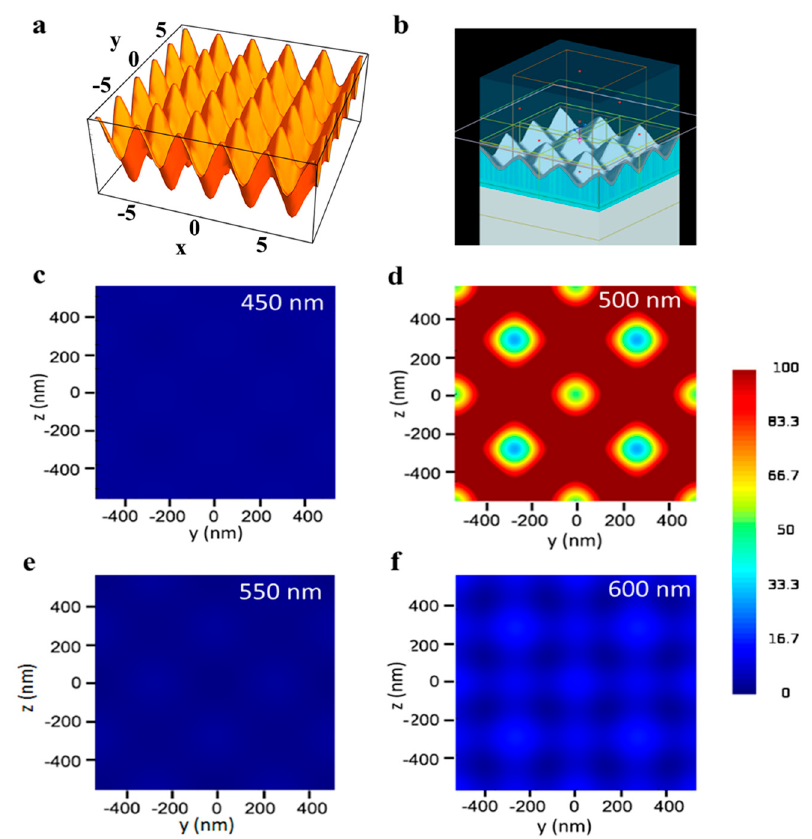
Figure 2. Finite-difference time-domain (FDTD) simulations. ( a ) 3D surface created from Equation (3). ( b ) FDTD simulation model. ( c – f ) Electric field distribution along xy cross-section for Ag TS-CSRGs with grating pitch spanning from 450 nm to 600 nm, with 50 nm increments.